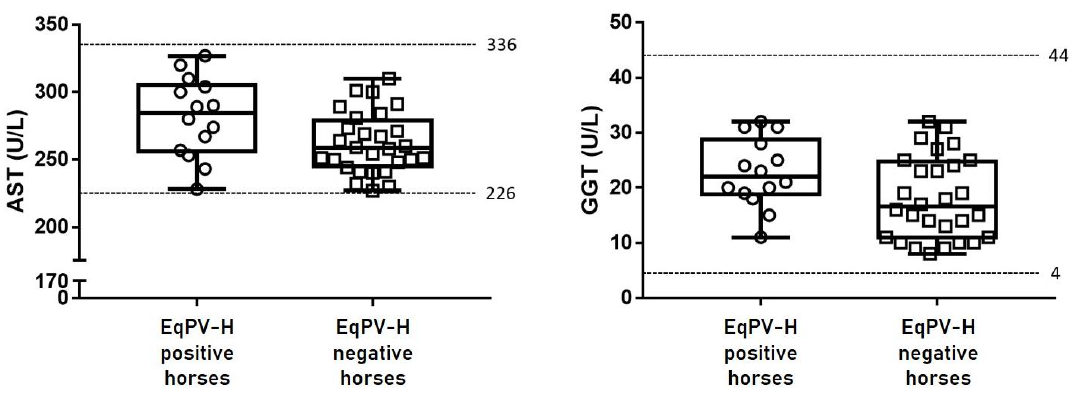
Figure 2. Liver-specific biochemical parameters (aspartate aminotransferase (AST; reference range: 226–336 U/L) and γ -glutamyl transferase (GGT; reference range: 4–44 U/L)) in the sera of both equine parvovirus-hepatitis (EqPV-H)-positive ( n = 14) and EqPV-H-negative (control) horses ( n = 28). Values of both EqPV-H-positive and control horses were within the normal ranges, indicating that the animals were clinically healthy.